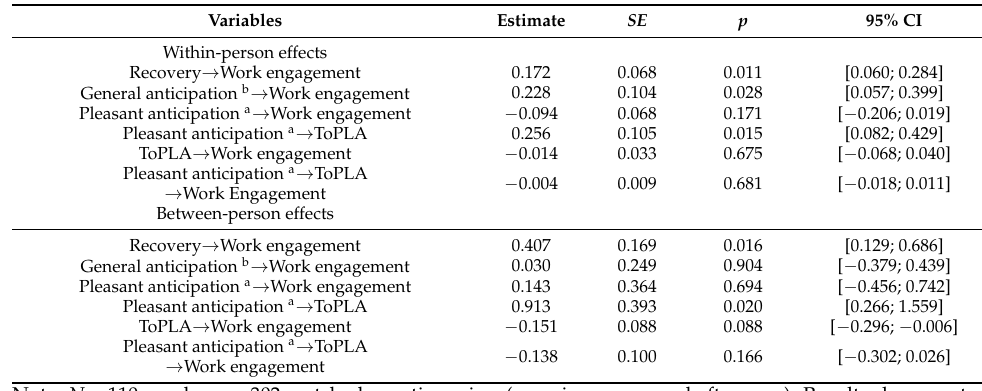
Table 2. Results from multilevel path